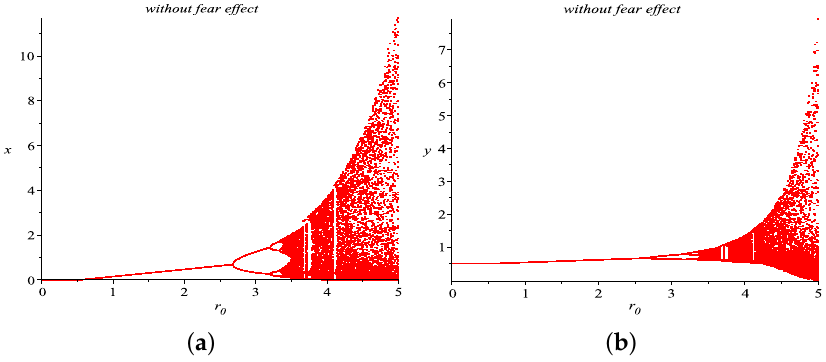
Figure 4. ( a ) The population density of prey varies with bifurcating parameter r 0 without fear effect ( k = 0), where other parameters are give in (58). ( b ) The population density of predator varies with bifurcating parameter r 0 without fear effect.